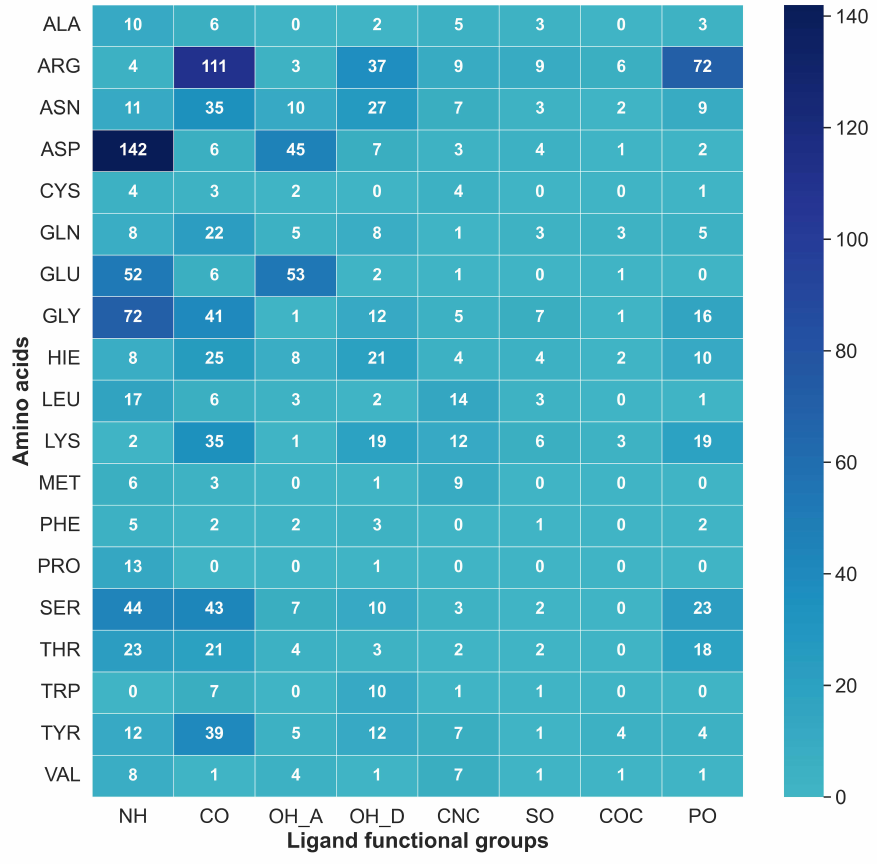
Figure 9. Total number of hydrogen bonds between each amino acid residue and eight most common ligand functional groups in the database B (occurrence map). Ligand functional groups are NH: N–H, CO: C=O, OH_A: O–H acceptor, OH_D: O–H donor, CNC: C–N–C, SO: S=O, COC: C–O–C and PO: